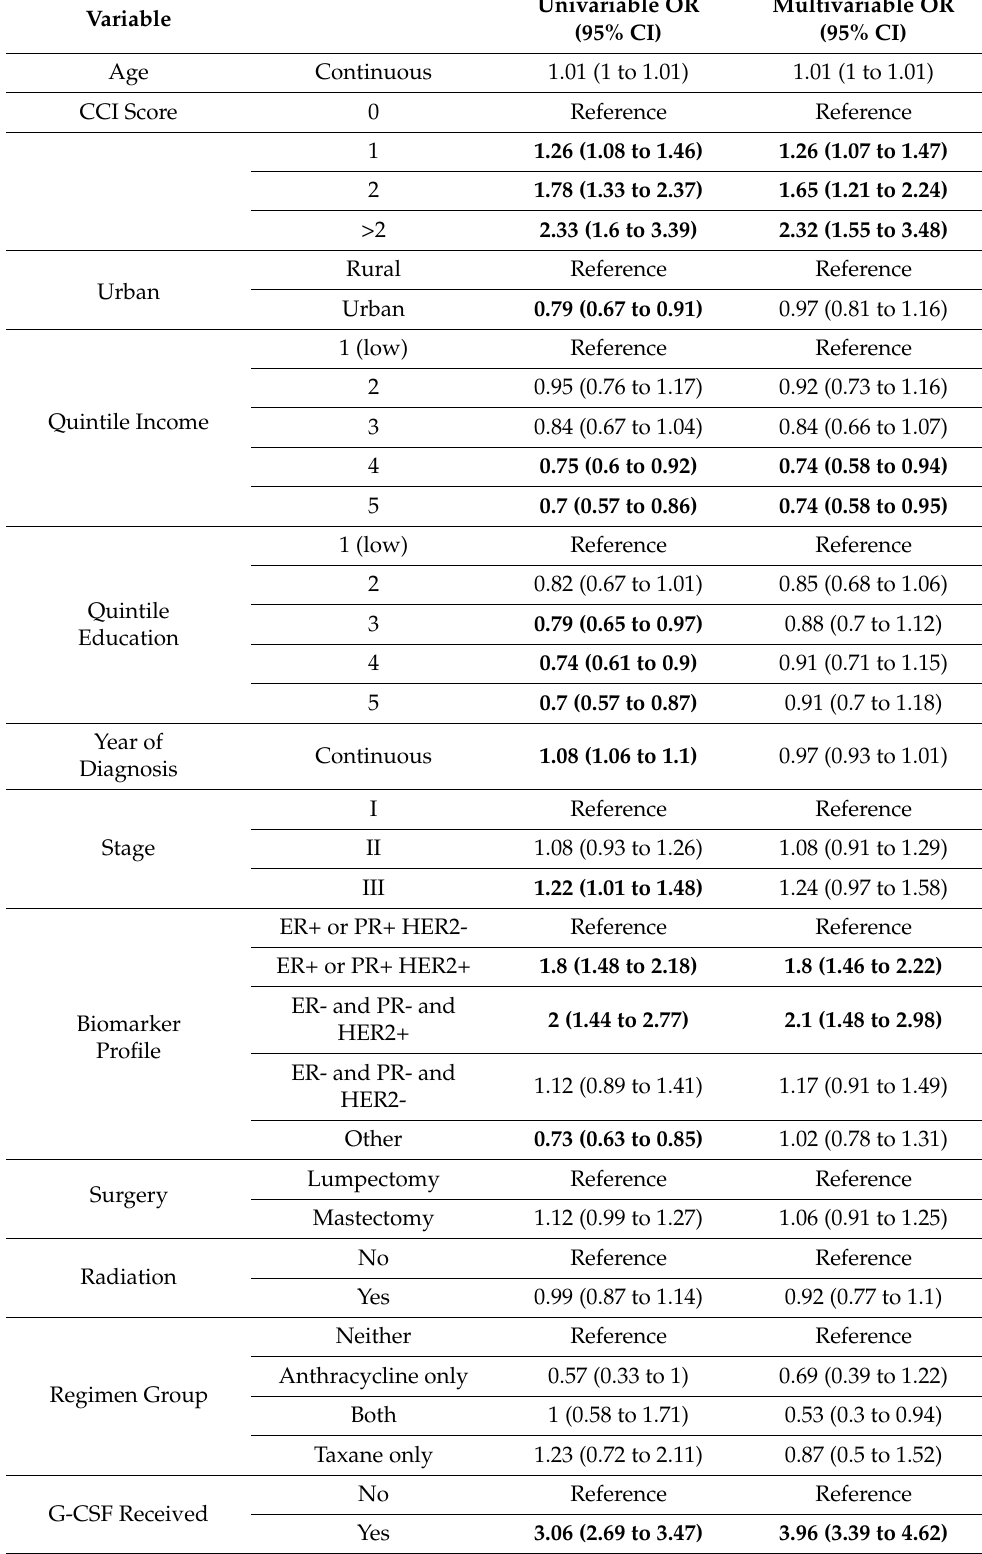
Table 3. Univariable and multivariable logistic regression models for ED → H. Statistically significant values are bolded. OR: odds ratio; CI: confidence interval; CCI: Charlson Comorbidity index; G-CSF: granulocyte-colony stimulating